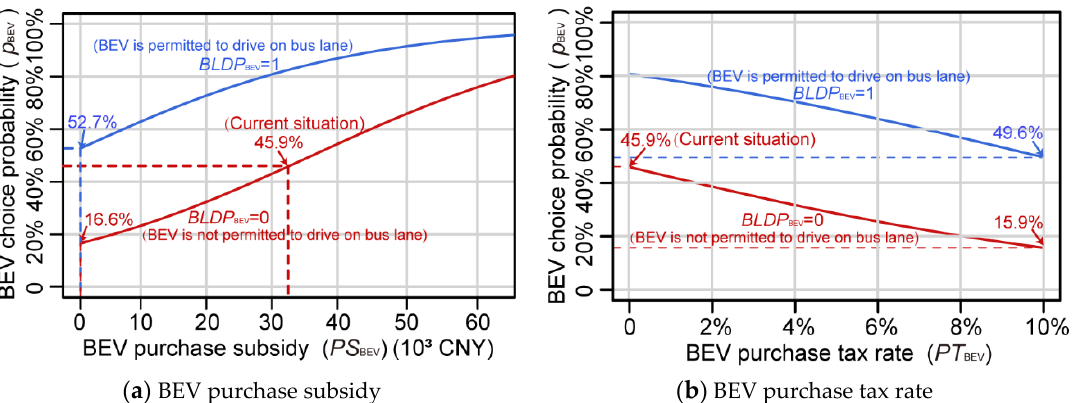
Figure 8. Alternative effects of the bus line driving permit (BLDP) against purchase subsidy policy phase-outs.